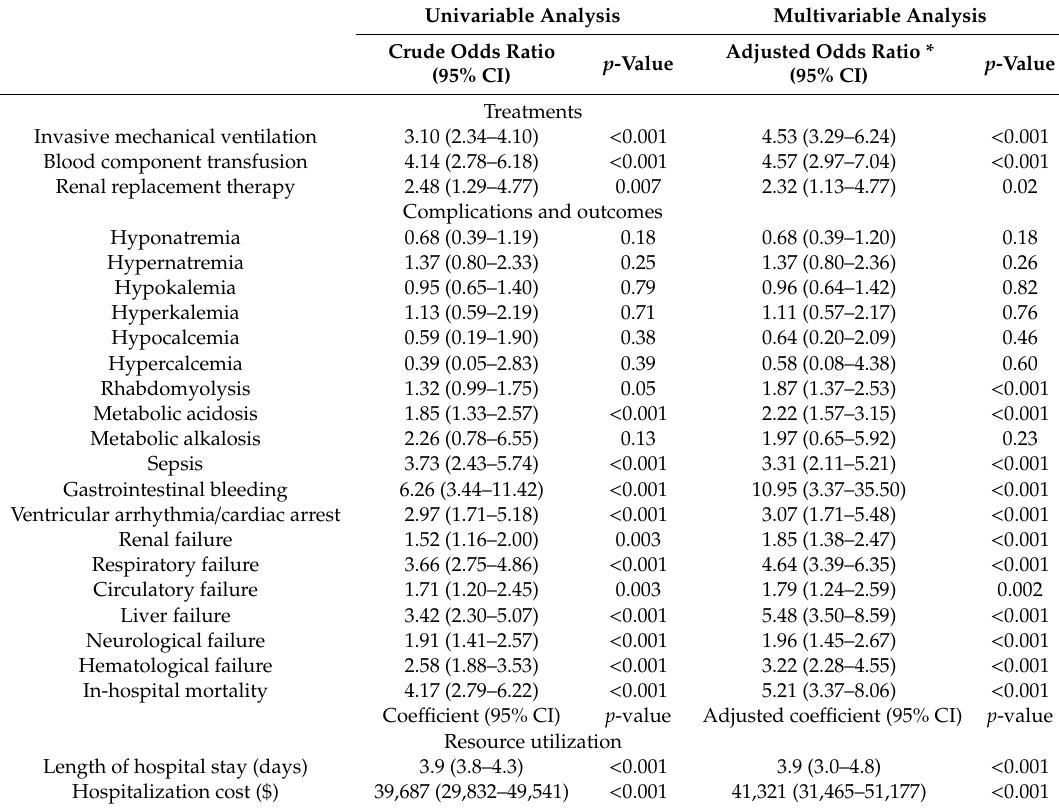
Table 3. The association between acute myocardial infarction and in-hospital treatments, complications, outcomes, and resource utilization in heat stroke